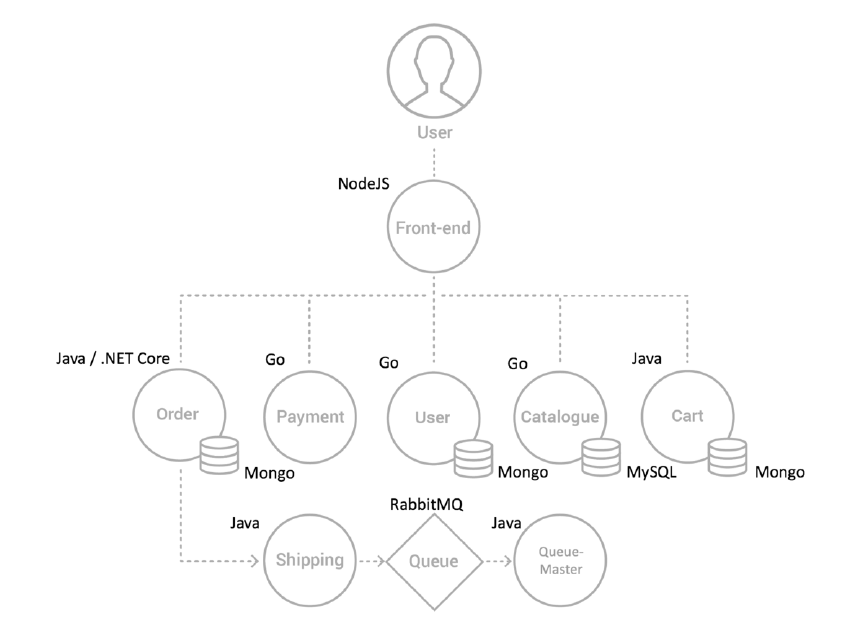
Figure 10. Sock Shop architecture.